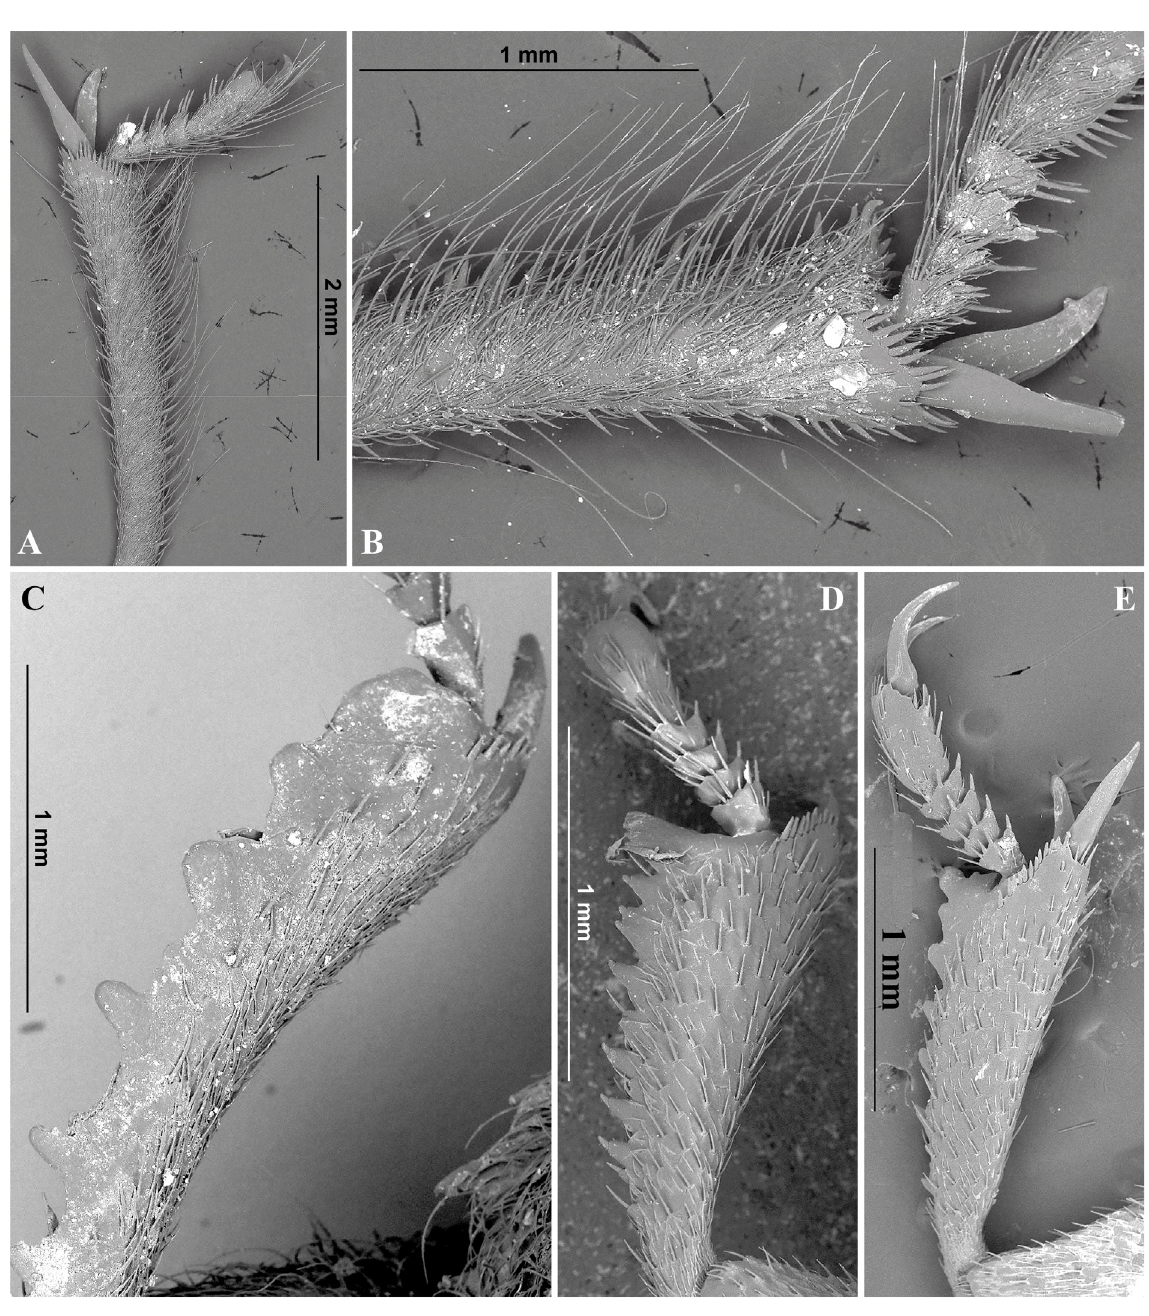
Fig. 28. Protibiae of Pimeliini, SEM. A . Przewalskia dilatata (Reitter, 1887), ♂ (ZIN), dorsal view. B . Ditto, ventral view. C . Earophanta serrata (Semenov, 1893), ♂ (ZIN), dorsal view. D . Platyope leucogramma (Pallas, 1773), ♂ (ZIN), dorsal view. E . Platyope grumi (Semenov, 1893), ♂, paralectotype (ZIN), dorsal